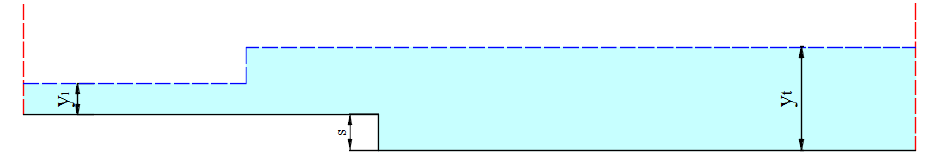
Figure 4. Schematic figure of the geometrical setup. Solid black lines indicates solid walls, dashed blue lines the initial free surface and dashed red lines show the position of the periodic open boundaries.